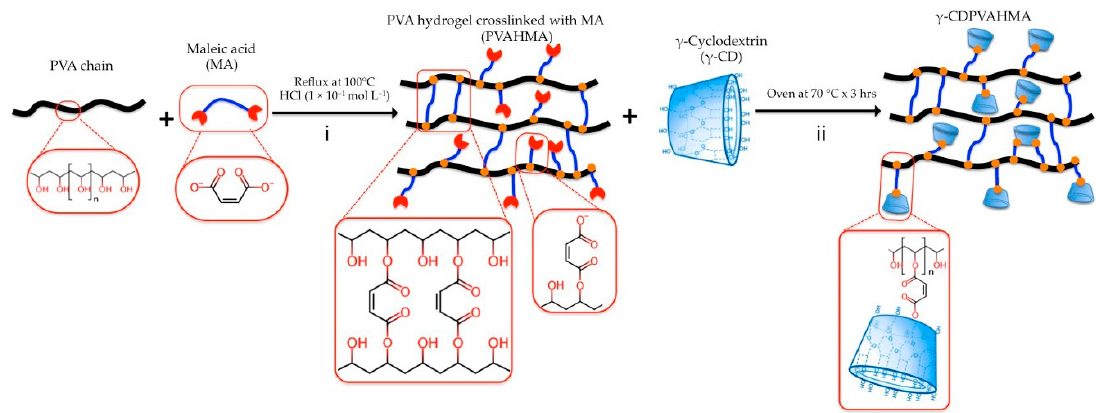
Figure 1. Schematic depiction of γ -CDPVAHMA (Polyvinyl alcohol hydrogel cross-linked with maleic acid and also linked with γ -cyclodextrin molecules). General syntheses were divided into two phases. First phase (pre-gel solution): Crosslinking reaction of PVA by esterification using MA as crosslinking agent. Second phase: Crosslinking reaction of PVA-MA (pre-gel solution) with γ -CD. Scheme was based on the process published by Marican et al. (2018)